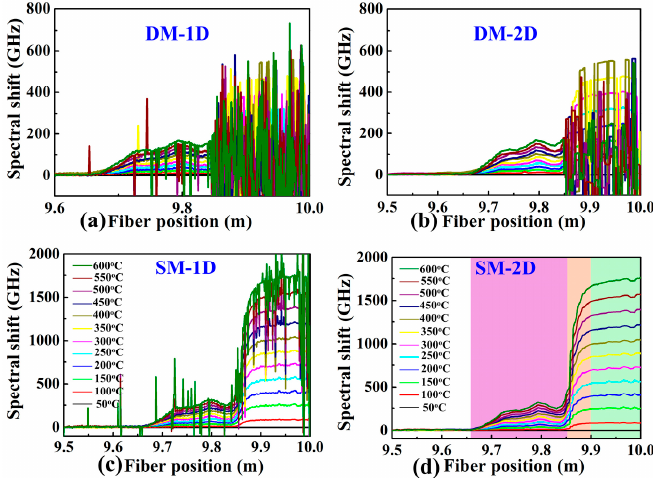
profile between 9.65 and 9.90 m, i.e., the outside and top of the furnace cavity, was obtained, while a relatively uniform temperature profile between 9.90 and 10.0 m, i.e., the inside the furnace cavity, was obtained.